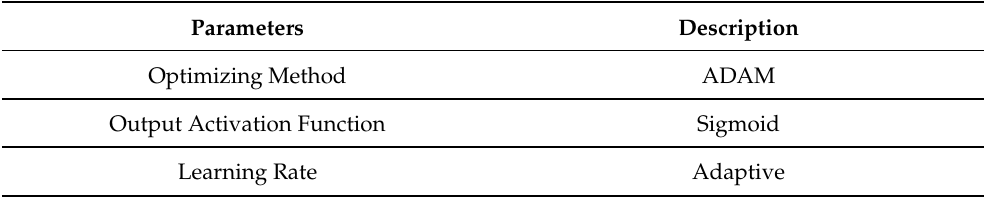
Table 1. Parameters of the NN attack method for ( x , y